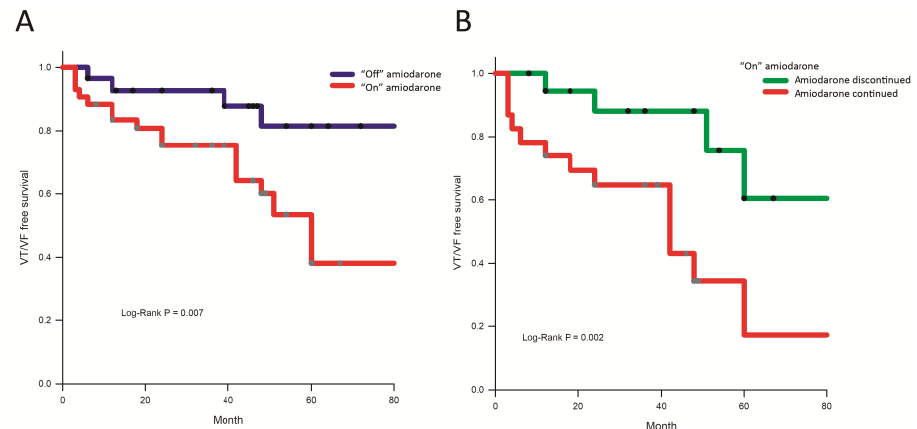
Figure 4. Kaplan–Meier curve for ablation outcomes during follow-up. ( A ) The Kaplan–Meier curve showed the recurrence-free survival in patients “on” and “off” amiodarone. Higher VT/VF recurrences were observed in patients “on” amiodarone than in those “off” amiodarone. ( B ) The Kaplan – Meier curve demonstrated the VT/VF recurrence-free survival in the patients with or without con- tinuous amiodarone use after the successful ablation in patients “on” amiodarone before CA.